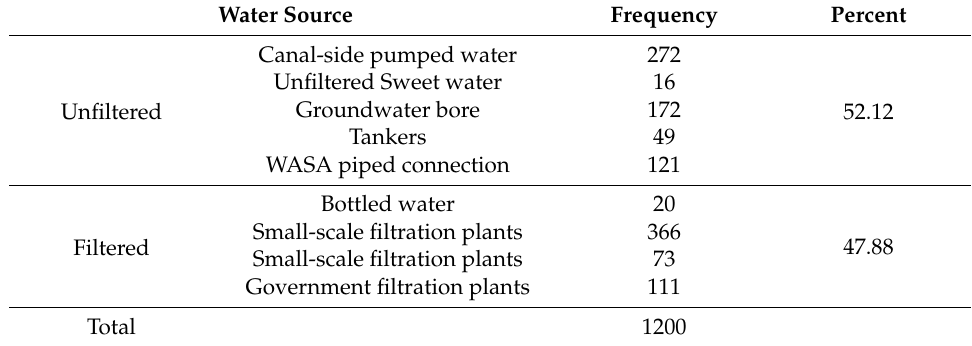
Table 2. Different sources of filtered and unfiltered